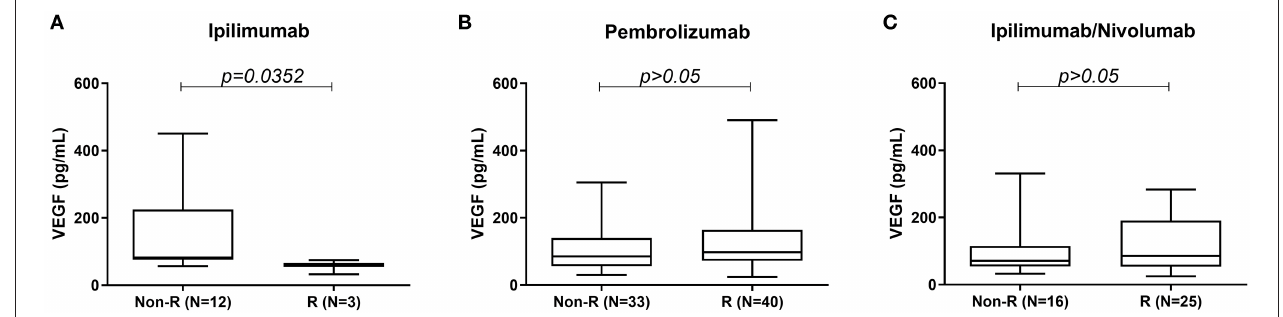
FIGURE 2 | Kaplan–Meier curves of patients treated with ipilimumab (A,D) pembrolizumab (B,E) and ipilimumab/nivolumab (C,F) , with high and low serum VEGF levels on progression free survival (PFS) (A–C) and overall survival (OS) (D–F) . (G) Cut-off finder curves representing the hazard rations (HR) and 95% Confidence Intervals (CI) obtained a t multiple cut-off values from 70 to 160 pg/mL of serum VEGF.